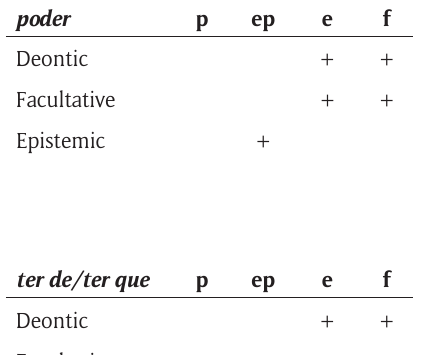
Table 6: Uses of ter de/ter